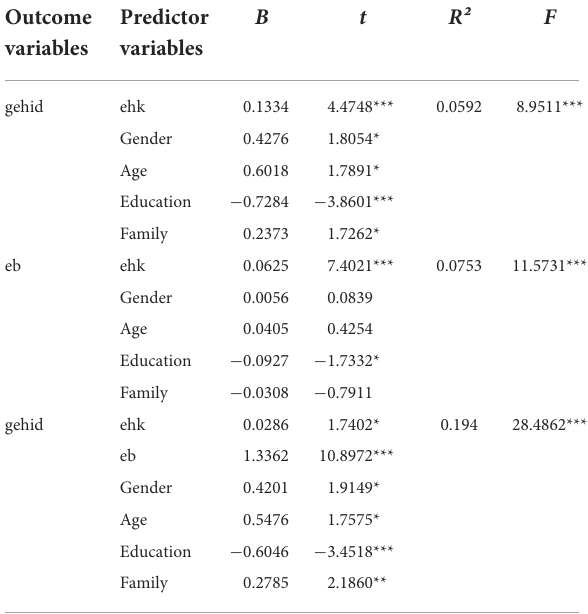
TABLE 4 Regression results.